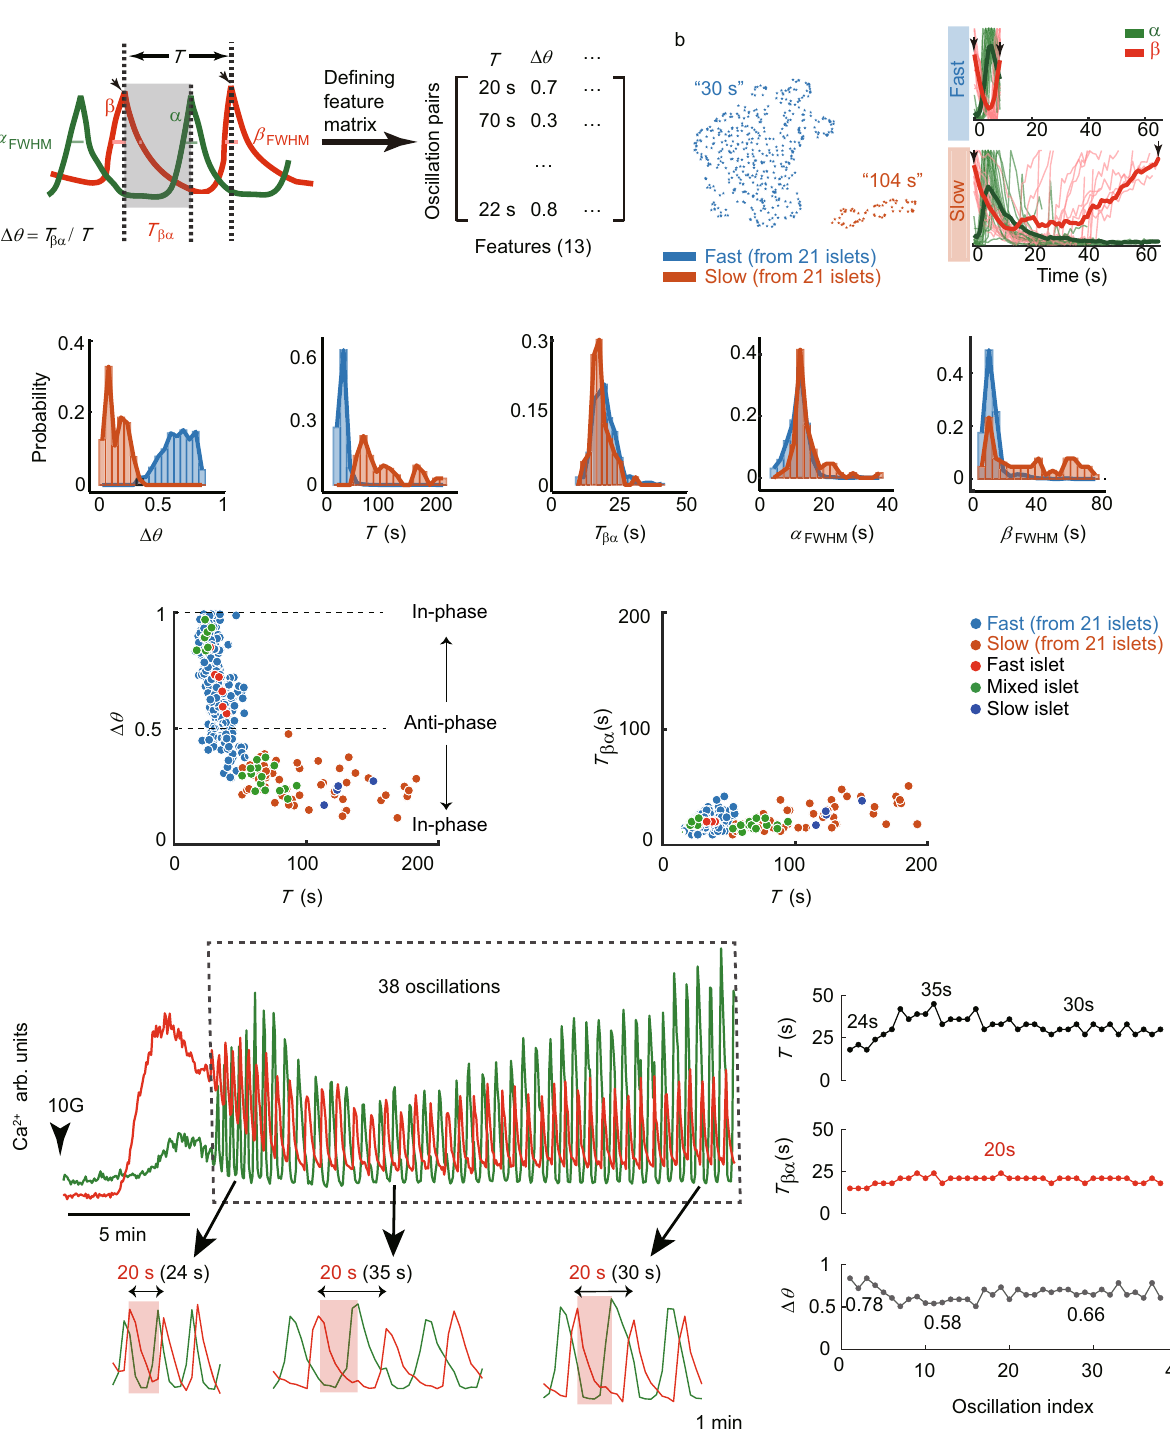
we de fi ned 13 features that recapitulated different characteristics of the α and β cell Ca 2 + dynamics, such as the rise and decay time of the activation for α and β cells, the Full Width at Half Max- imum (FWHM) (Table 1, and see Methods for detailed de fi ni- tions and Source Data). Based on these parameters, the oscillating cycles were vectorized and assembled into a feature matrix. Next, by dimension reduction of these parameters with the UMAP algorithm 49 , oscillations could be classi fi ed into fast and slow ones (Fig. 4b), in which T , Δ θ and FWHM of β cells demon- strated signi fi cant inter-group differences (Fig. 4c